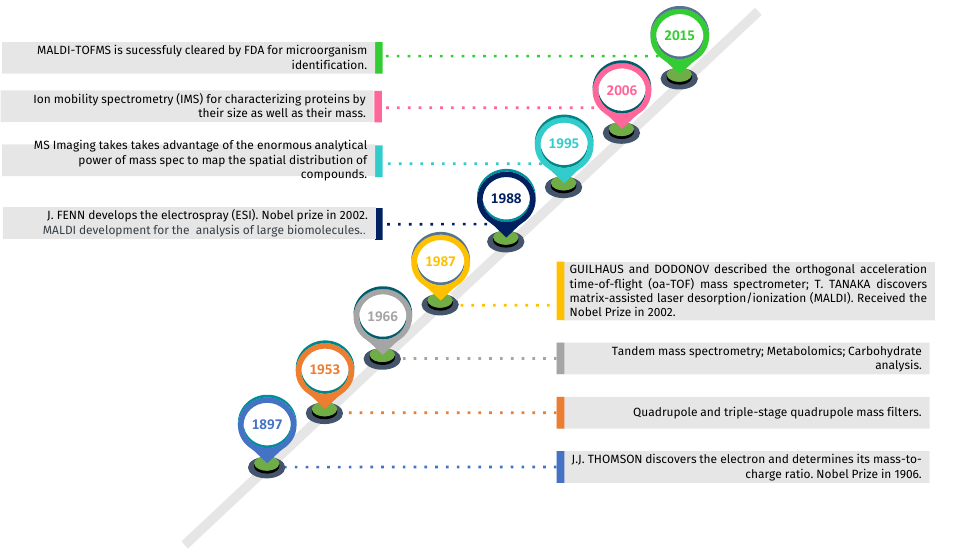
Figure 2. Some important milestones responsible for the important advances in MS.